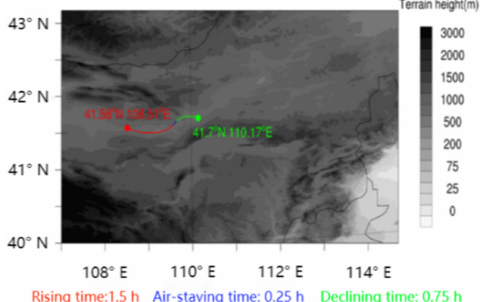
Figure 5. The locations where the equipment box was launched (red point) and recycled (blue point).